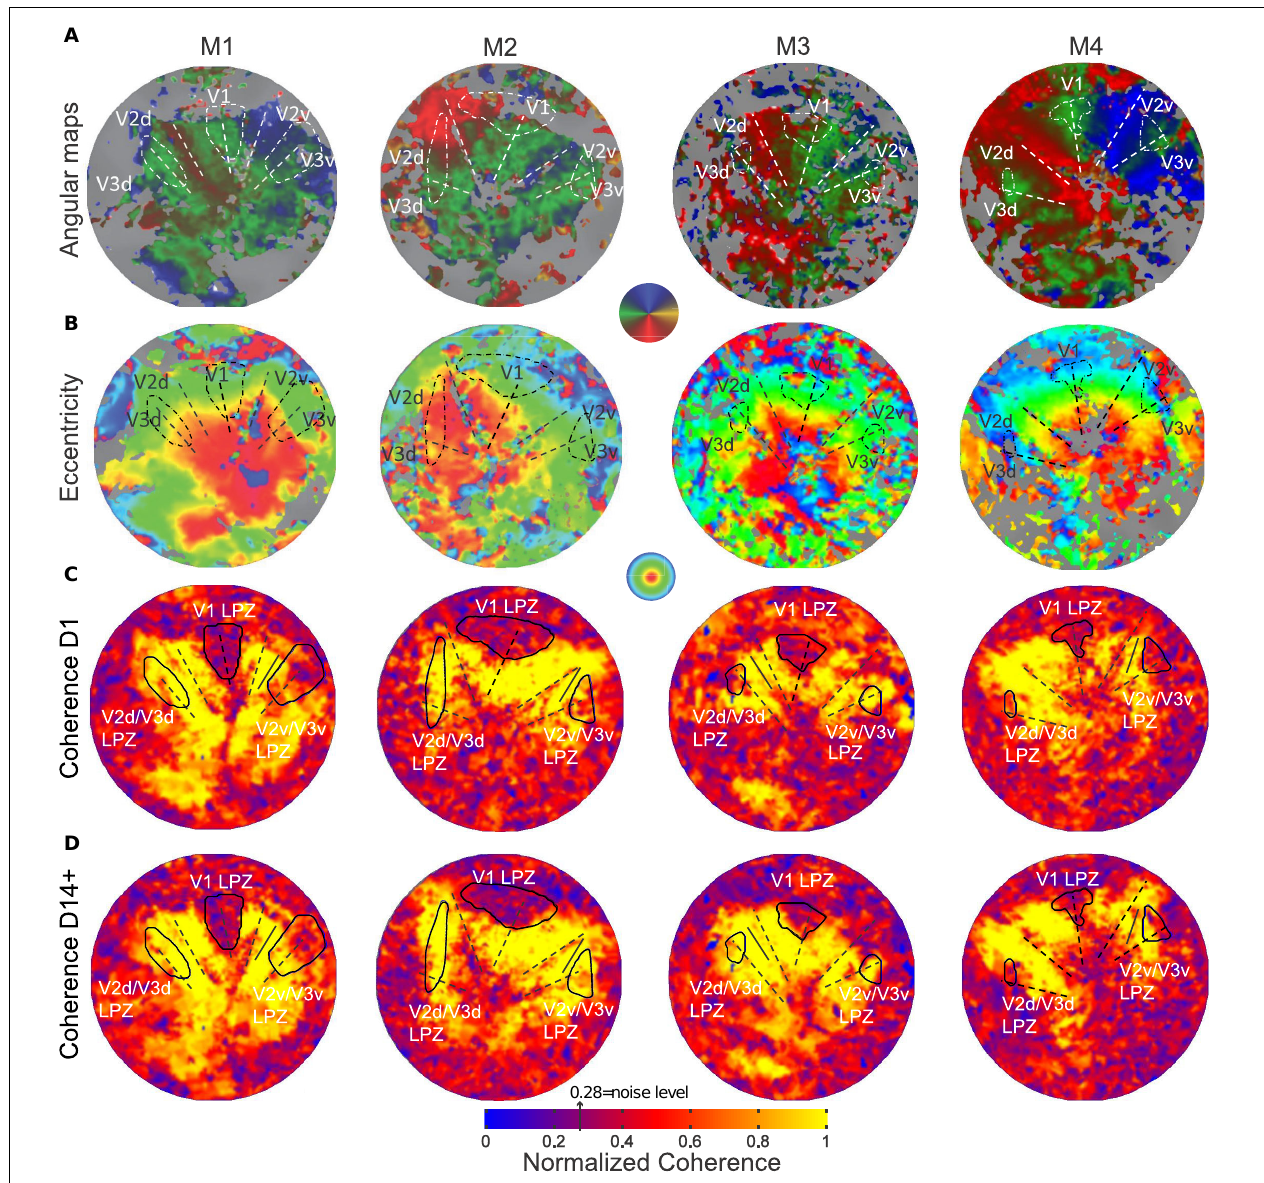
FIGURE 2 | Pre-lesion retinotopy and LPZ definition. (A) Polar angle and (B) eccentricity functional activation maps obtained pre-lesion and overlaid on the flattened representation of early visual cortex in monkeys M1, M2, M3 and M4. (C) Normalized coherence maps of the hemispheres affected by the retinal lesion, obtained on the day of the lesion (D1) and (D) at least 14 days post-lesion using the ring stimulus (14 days post-lesion for monkeys M1, M3 and M4, 62 days post-lesion for M2). The V1 LPZs were selected directly based on the coherence maps (see section “Materials and Methods”). V2v/V3v and V2d/V3d LPZs were defined on the atlas fit of the pre-lesion retinotopic maps (Dougherty et al., 2003), by extracting voxels in areas V2 and V3 with similar eccentricities and polar angles as voxels in the V1 LPZ (see section “Materials and Methods”). The color map of coherence is normalized with respect to the average coherence across the voxels of an approximately iso-angular non-deafferented area V2 ROI (solid black line segment). The V1/V2 and V2/V3 borders and the V1 horizontal meridian are shown as dashed lines.